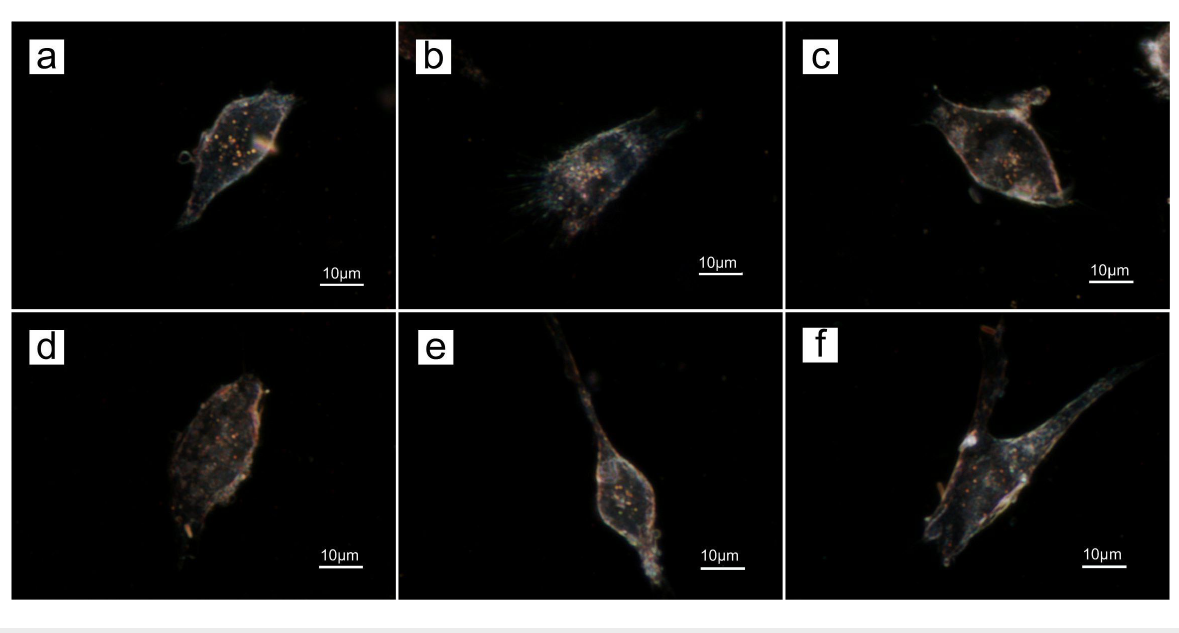
Figure 7: Dark-field images of OSCC cells with AuNRs encapsulated with (a) 10 nM, (b) 1 µM, (c) 1 mM of PEG-SH and (d) 10 nM, (e) 100 µM (f) 1 mM of Pluronic F127.